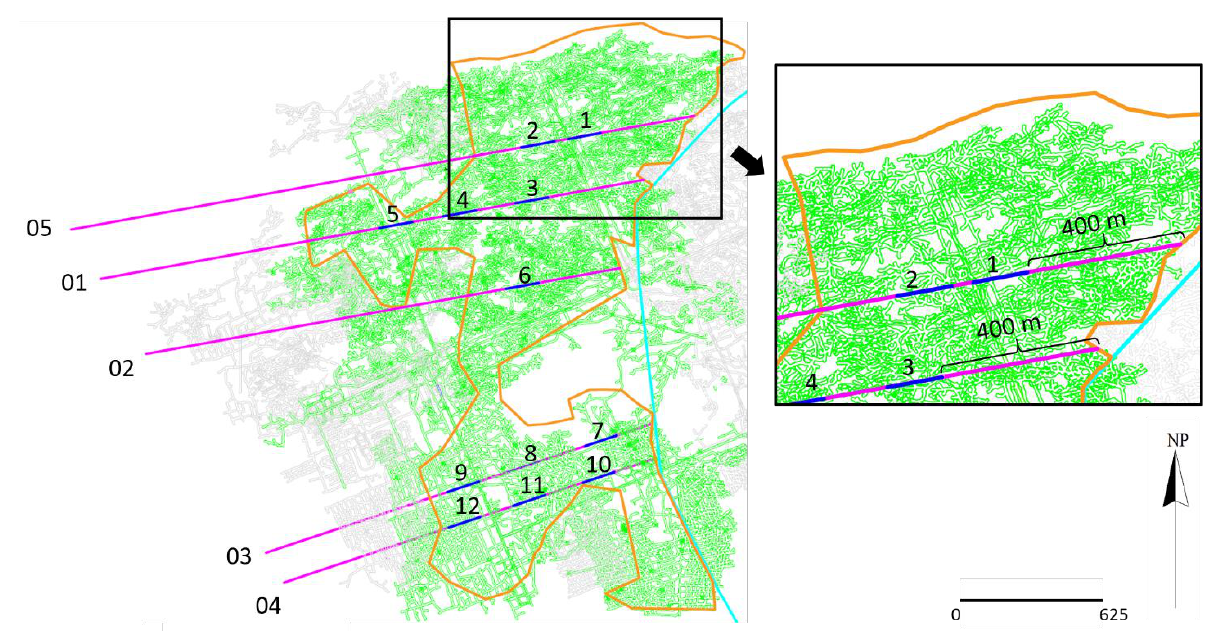
Figure 1. The mining area, with the two different perimeters, the five profiles and the twelve selected zones shown. The numbers on the left show the ID of each profile (from 01 to 05). The numbers enclosed in the orange perimeter show the ID of each analysed zone (01 to 12).